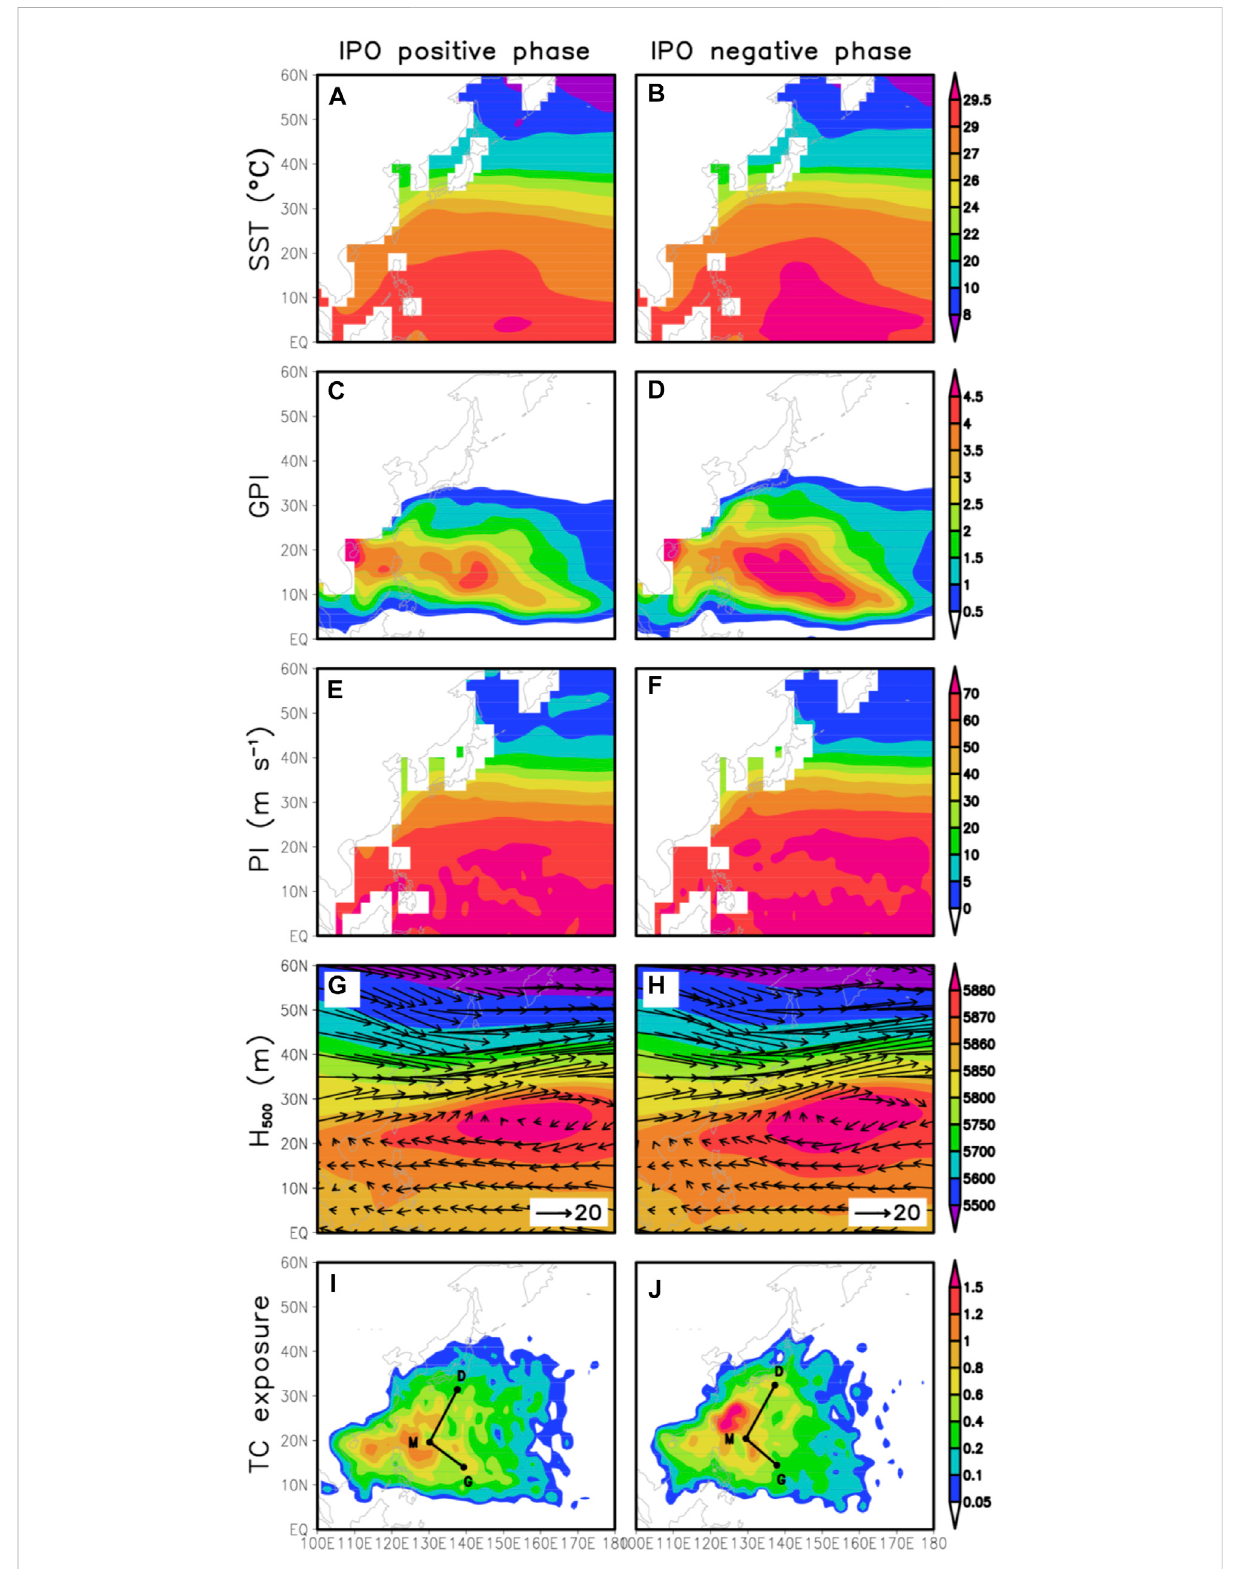
FIGURE 6 Annual-meanJASONSST,GPI,PI,large-scale circulation,and TCexposureduring thepositive IPOphase (A,C,EandG) andnegativeIPO phase (B,D,F and H) . (A,B) SST ( ° C); (C,D) GPI; (E,F) PI (m s − 1 ); (G,H) 500-hPa geopotential height (shaded; m) and 850 – 300 hPa vertically averaged wind (vectors;ms − 1 );and (I,J) TCexposure(numberofdaysofexposureperyearper2 ° ×2 ° latitude – longitudegridbox)andthepositionsofTCgenesis(G), lifetime maximum intensity (M), and disappearance